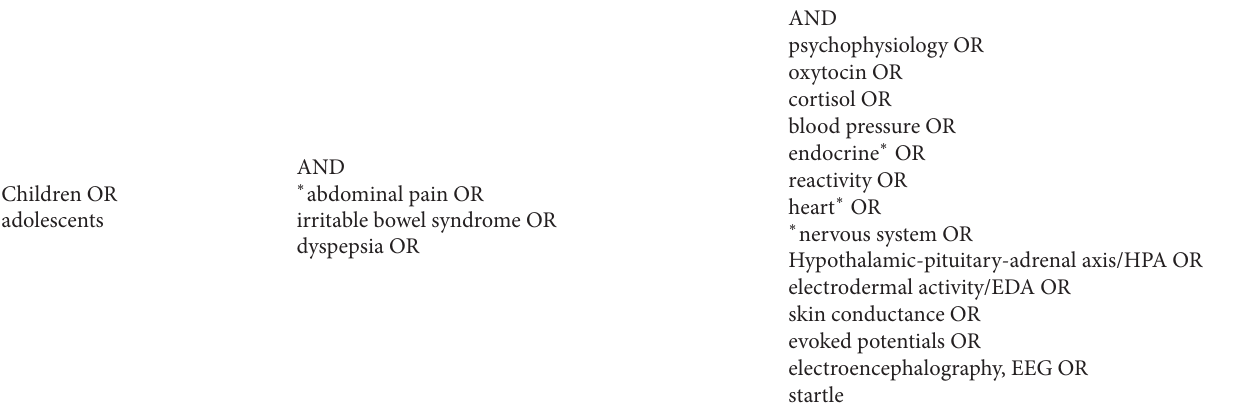
Table 1: Variable combination of English keywords used for paper